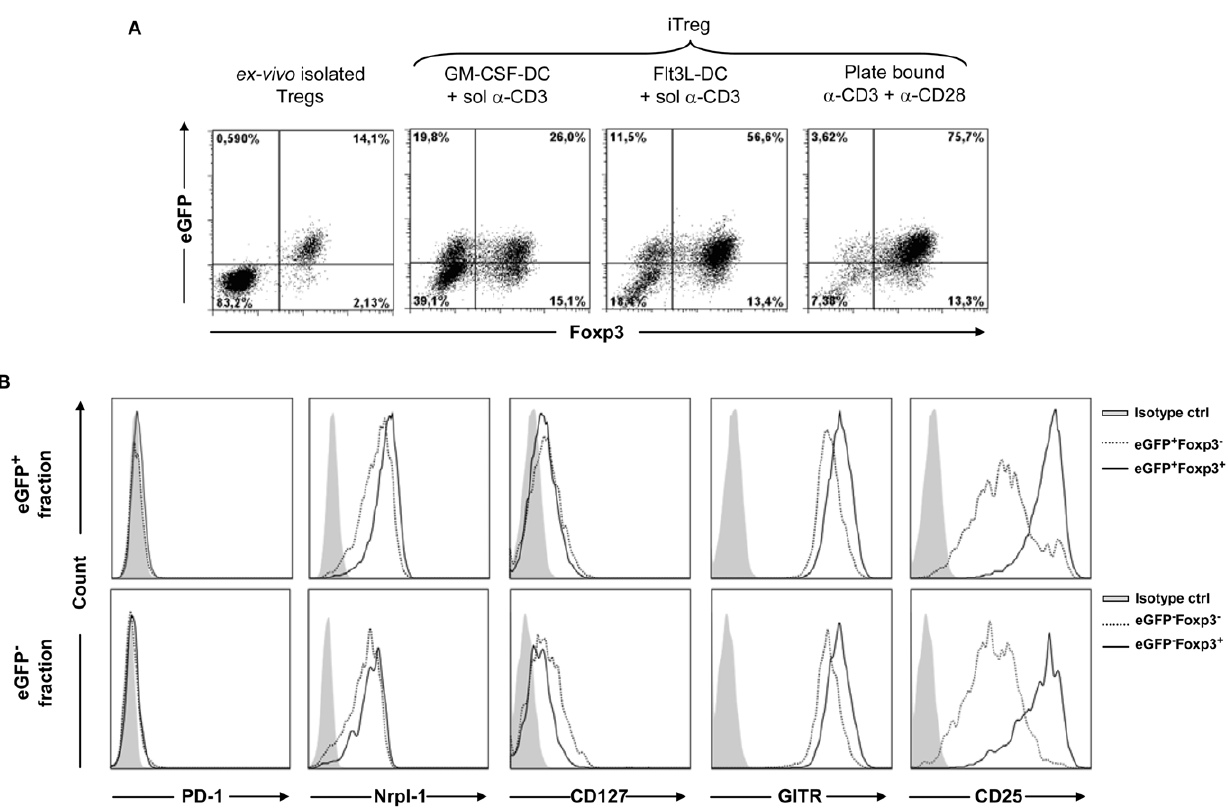
Figure 1. Culture conditions demonstrating eGFP and Foxp3 expression dichotomy amongst in vitro generated iTregs from DEREG mice. (A) Dot plots display eGFP and Foxp3 expression among the live CD4 + gated DEREG cells. Shown are ex vivo stained T cells (left), in vitro differentiated iTregs using soluble anti-CD3, TGF- b , RA and GM-CS- or Flt3L-derived BMDC (second and third panels respectively) and iTregs using plate-bound anti-CD3, anti-CD28, TGF- b and RA (right). (B) Differential expression of various surface antigens on eGFP + Foxp3 2 (dotted line, upper panel) and eGFP + Foxp3 + (solid line, upper panel) iTregs and eGFP 2 Foxp3 2 (dotted line, lower panel) and eGFP 2 Foxp3 + (solid line, lower panel) cells differentiated in the presence of TGF- b , RA, soluble anti-CD3 and DC. Gray histograms represent isotype controls. Graphs shown are representative of four individual experiments.